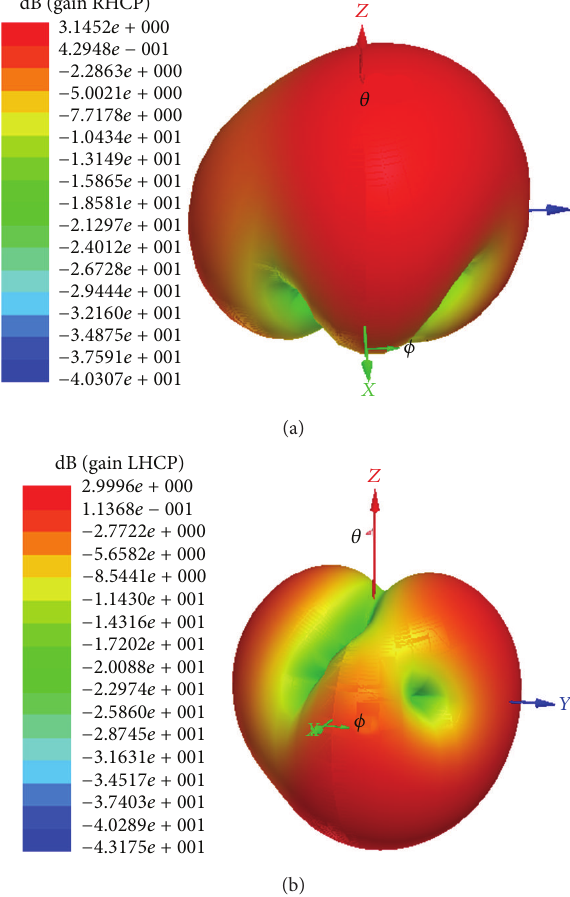
Figure 2: 3D radiation patterns of the proposed antenna. (a) RHCP pattern. (b) LHCP pattern.